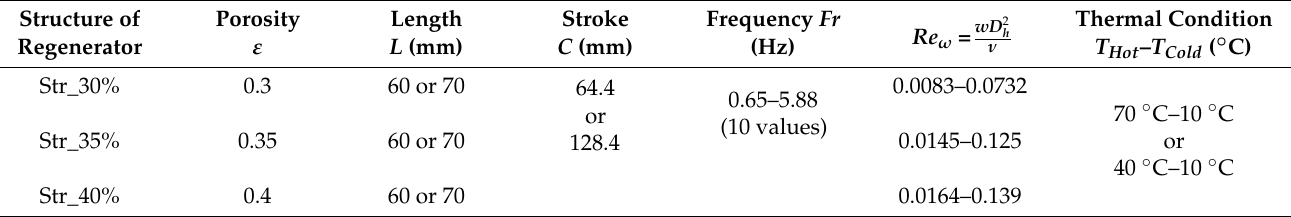
Table 2. Test conditions for alternating